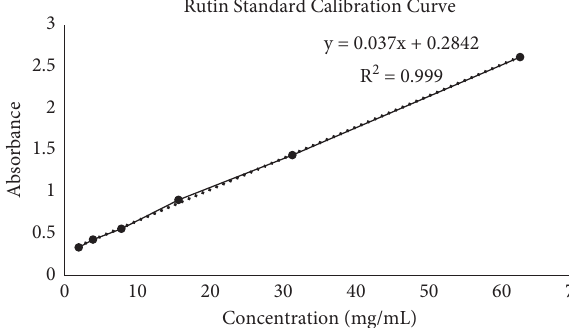
Figure 3: Standard calibration curve of rutin.